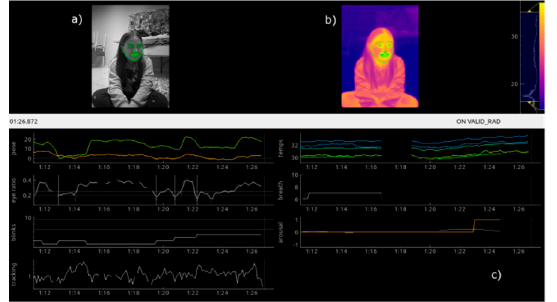
Figure 2. Example of analysis of thermal signals. The coordinates of the landmarks detected in the visible image ( a ) are reported on the corresponding thermal image ( b ). The data extracted for the application ( c